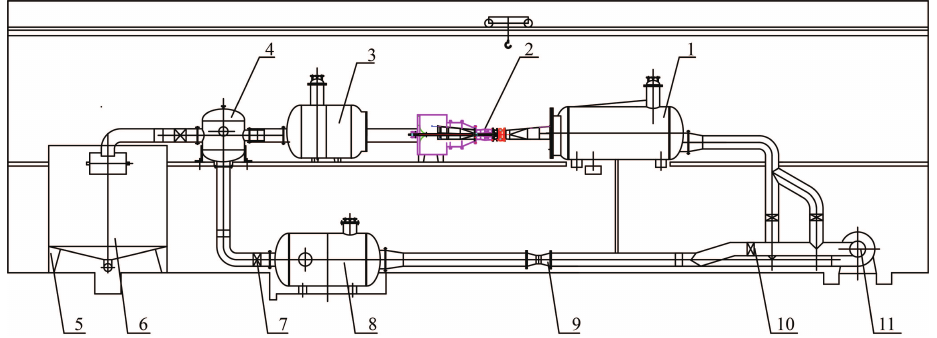
Figure 3. Schematic diagram of high-precision hydraulic machinery test bench: (1) Inlet tank; (2) Tested pump device and drive motor; (3) Pressure outlet tank; (4) Bifurcated water tank; (5) Weigh- ing sensor; (6) In-situ calibration device; (7) Adjusting gate valve; (8) Stabilized rectifier cylinder; (9) Electromagnetic flowmeter; (10) Control gate valve; (11) Auxiliary pump unit.